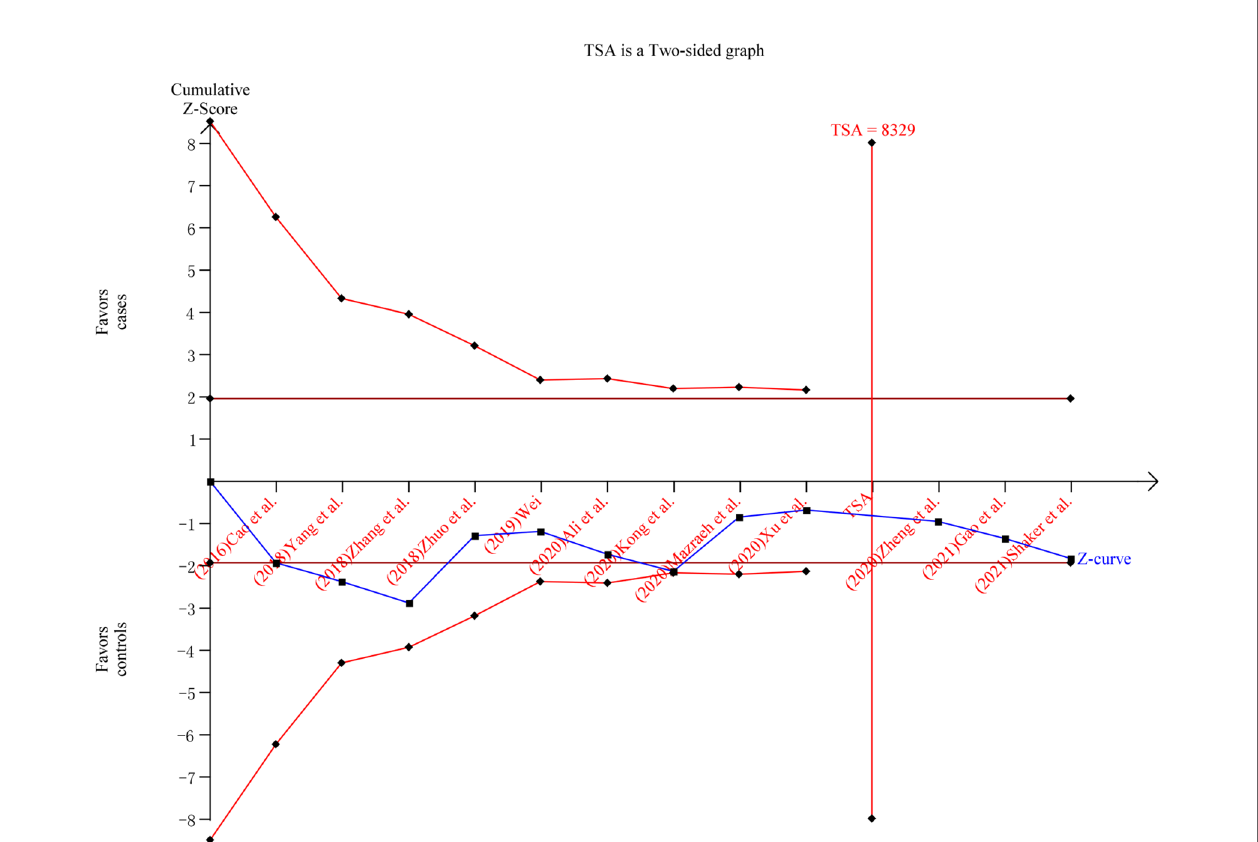
FIGURE 3 | Trial sequential analysis of the current meta-analysis under the (AA+AG) vs. GG